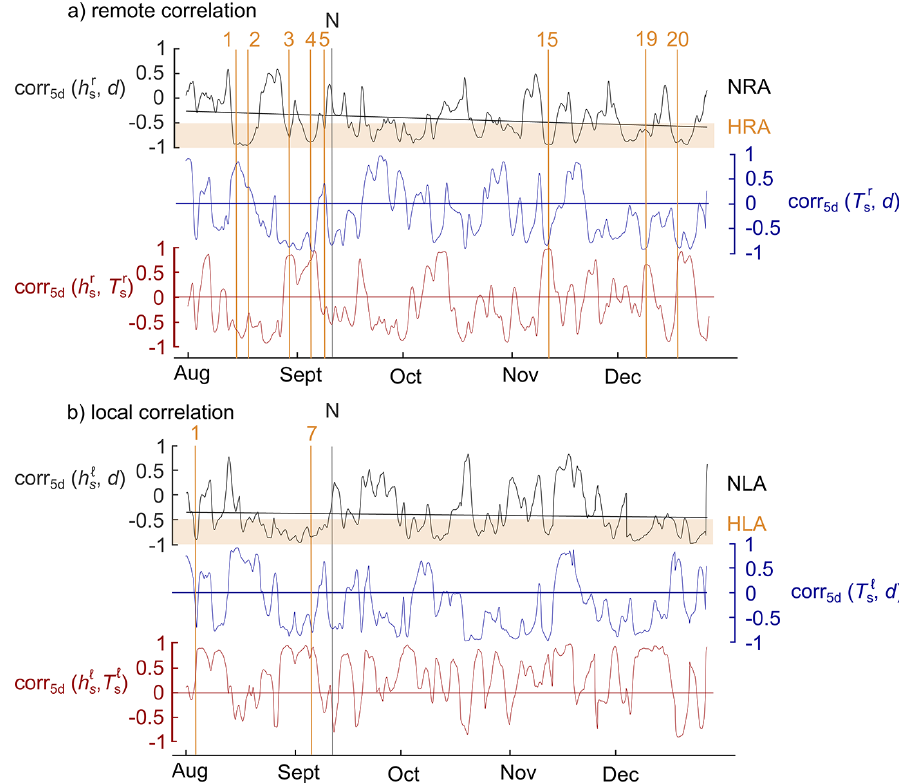
Fig. 8. (a) Five-day moving window correlation between 24h filtered d measurements and moisture source h r s and T r s conditions. The orange band in the corr 5day (h r s ,d) plot identifies HRA events. Time periods with 0 . 5 > corr 5day (h r s ,d) > − 0 . 5 are identified as NRA events. The black solid line in the corr 5day (h r s ,d) plot represents a linear fit to the moving window correlation curve. The straight blue and red lines show corr 5day (T r s ,d) = 0 and corr 5day (h r s ,T r s ) = 0. (b) As in (a) but moving window correlations are shown for local conditions. A few selected HRA and HLA events in (a) and (b) are marked by orange vertical lines (see text for details). The grey vertical line (N) indicates a 5-day period in which we find no anticorrelation of d either with locally measured h ‘ s or with remote h r s . The dates for the HRA and HLA events are given in Tables 5 and 6,